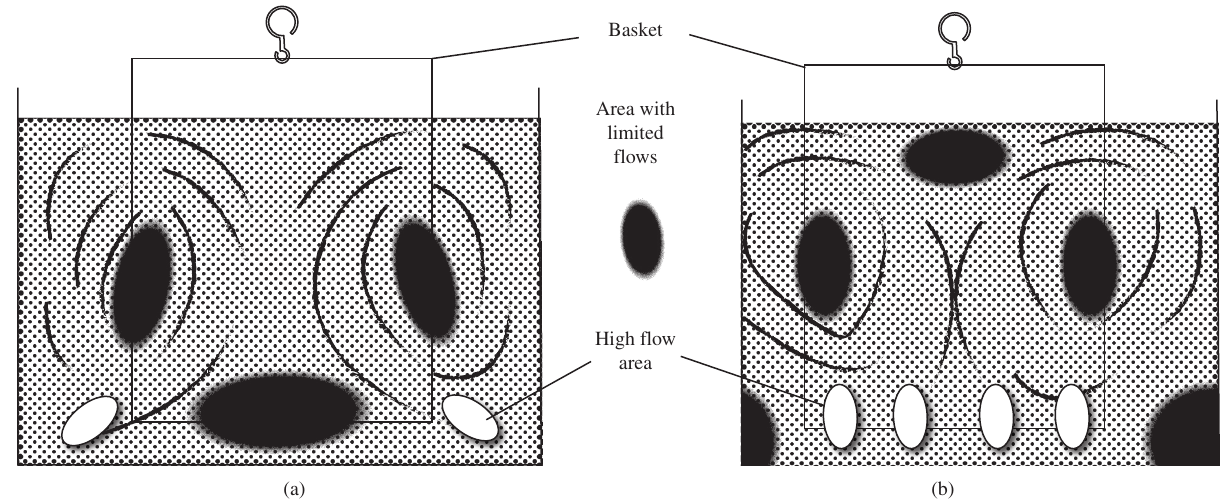
Figure 4. Effect of spray eductor placement on quench uniformity, a) Eductors placed at opposite bottom edges; and b) Eductors placed directly under the load.